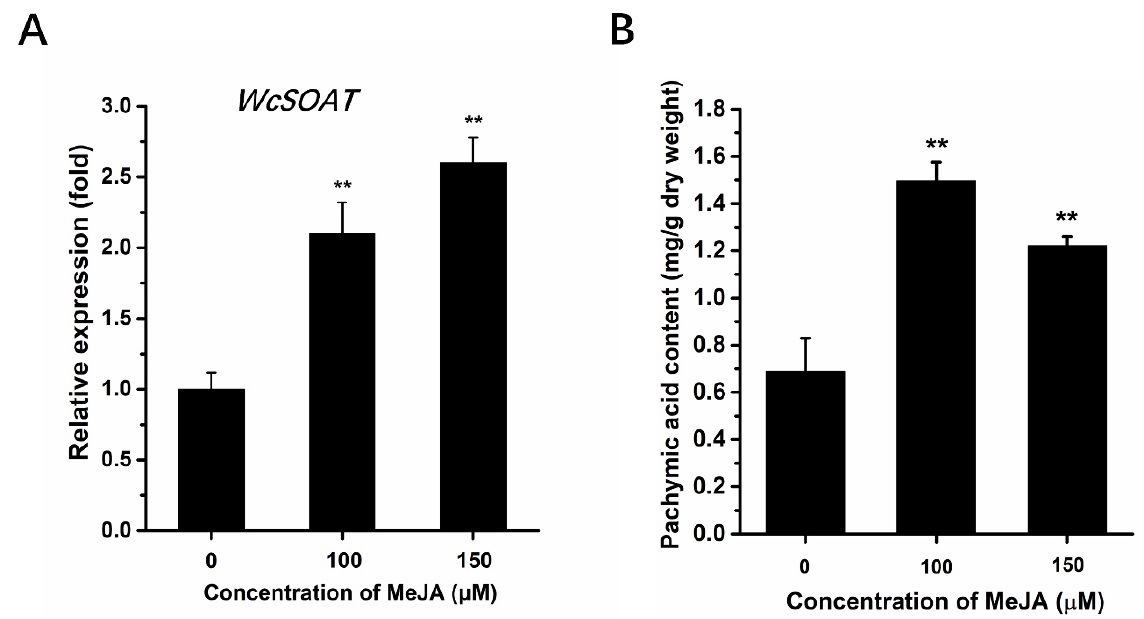
Figure 3. The effects of MeJA on WcSOAT gene expression and pachymic acid accumulation. ( A ) The relative expression level of WcSOAT in W. cocos after treatment with MeJA was evaluated by RT-qPCR. The expression level of WcSOAT in the sample treated without MeJA was set as 1, and relative transcript levels were calculated using the comparative Ct method. Transcript levels of the W. cocos his3-1 gene were used to normalize different samples. Data represent means and standard deviations of three independent replications. ( B ) The content of pachymic acid in W. cocos after treatment with MeJA. Data were obtained from three independent experiments with total 9 replicates. ** indicate statistical differences at p ≤ 0.01 compared with sample without MeJA treatment, one-way